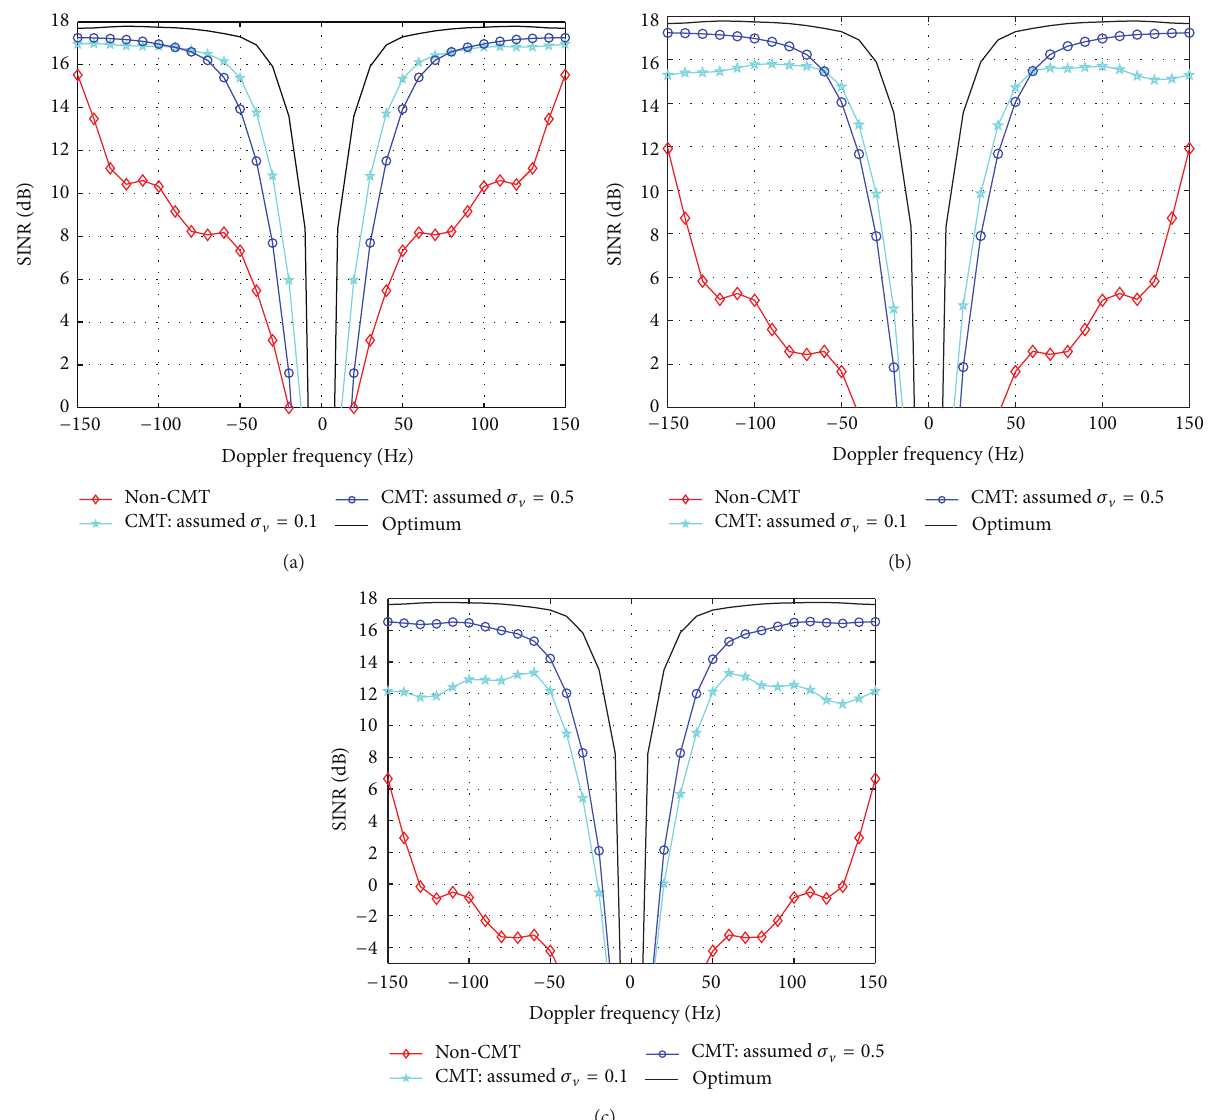
Figure 4: Impacts of velocity misalignment of prior knowledge on SINR performance against Doppler frequency with 4 snapshots and the target Doppler frequency space from − 150 to 150 Hz. (a) Velocity misalignment 0 . 5 m/s; (b) velocity misalignment 1m/s; (c) velocity misalignment